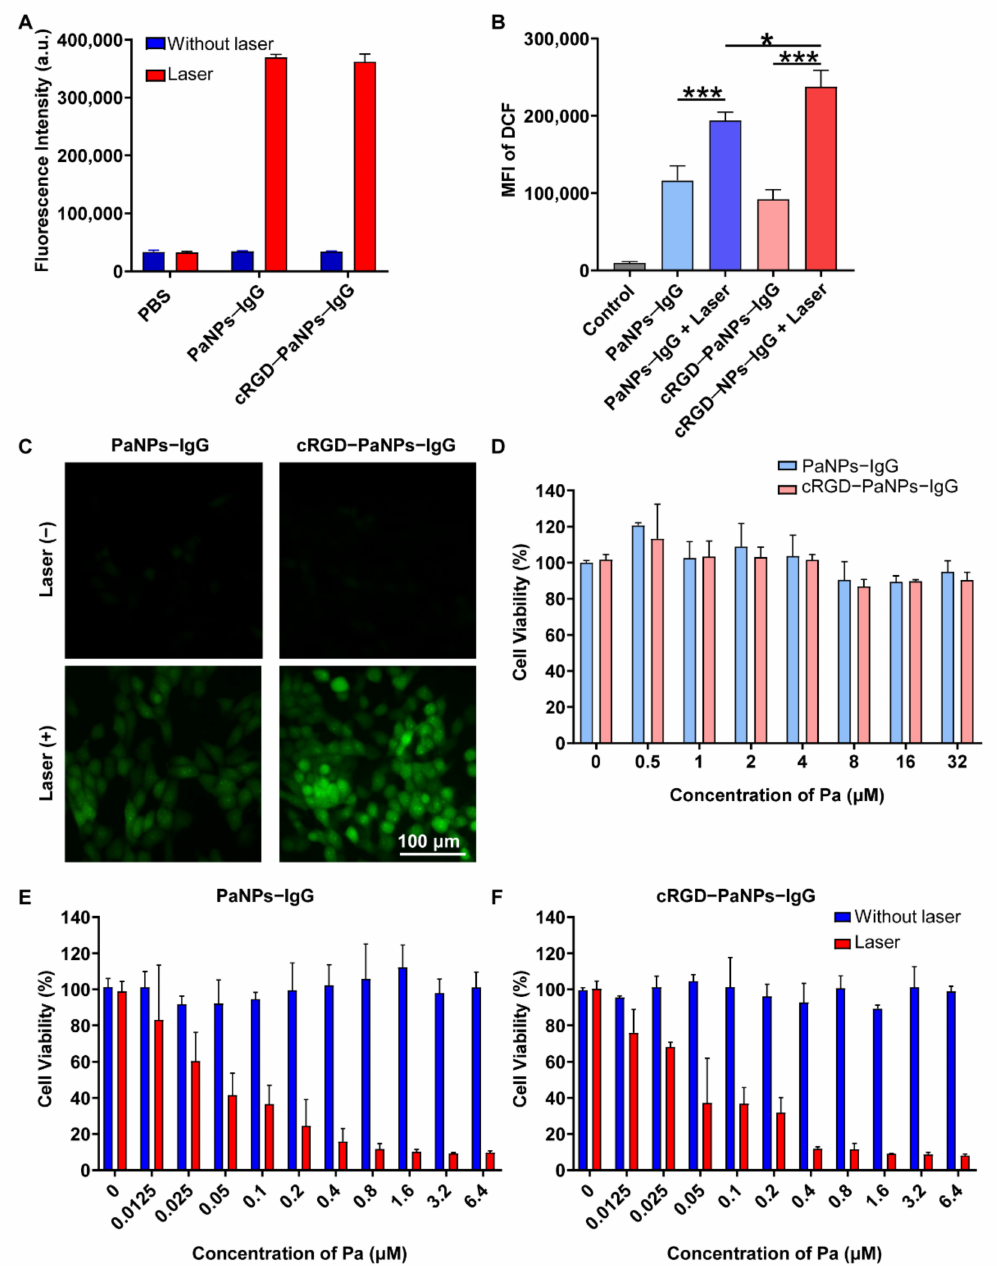
Figure 3. The PDT effect of cRGD–PaNPs–IgG in vitro. ( A ) Singlet oxygen generation of PaNPs–IgG or cRGD–PaNPs–IgG (5 µ M of Pa) with or without laser irradiation (660 nm, 20 mW/cm 2 , 5 min). ( B ) Mean fluorescence intensity (MFI) of 4T1 cells with different treatment followed by H2–DCFDA staining, analyzed by flow cytometry. 4T1 cells incubated with H2–DCFDA (10 µ M) at 37 ◦ C for 20 min after incubation with the PaNPs–IgG or cRGD–PaNPs–IgG (0.4 µ M of Pa) for 2 h. The laser treatment (660 nm, 20 mW/cm 2 , 5 min) was applied at 20 min after incubation with H2–DCFDA (10 µ M). ( C ) Fluorescence micrographs of the 4T1 cells following the treatment in ( B ). ( D ) Relative cell ability of NIH3T3 cells after the incubation with PaNPs–IgG or cRGD–PaNPs–IgG for 24 h. ( E , F ) Cell ability of 4T1 cells incubated with PaNPs–IgG ( E ) or cRGD–PaNPs–IgG ( F ) with or without laser treatment (660 nm, 20 mW/cm 2 , 5 min) at 2 h post–incubation. The cells were further incubated for 24 h for the MTT assay. Data are mean ± SD ( n = 3). * p < 0.05 and *** p <